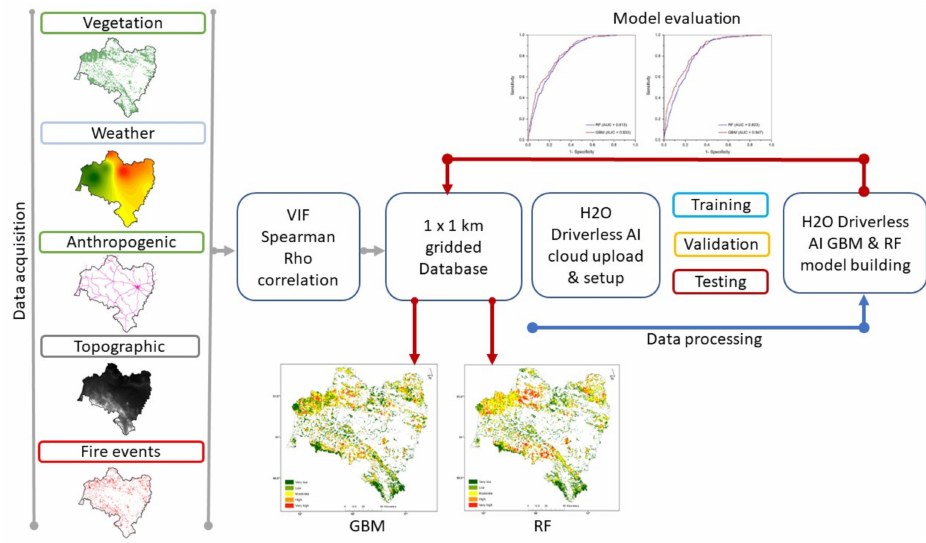
Figure 3. Data processing